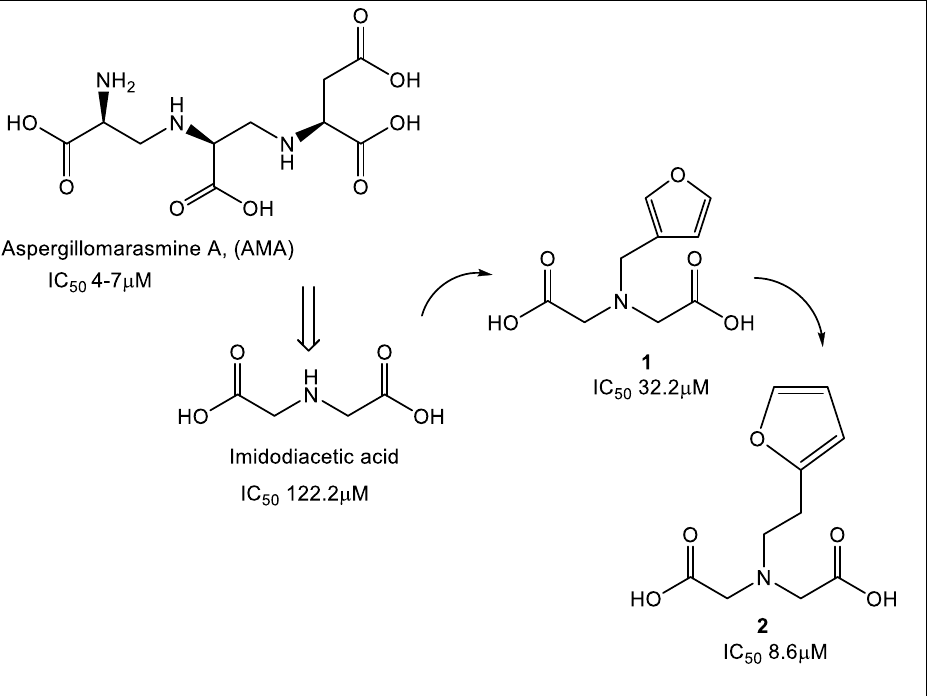
Figure 2. Fragments guide lead derivatization of NDM-1 based on the natural product aspergillo- marasmine A (AMA). Iminodiacetic acid (IDA), a simplified analogue of AMA, was successfully derivatized to compound 2 as NDM-1 inhibitor with IC 50 value similar to that of AMA.